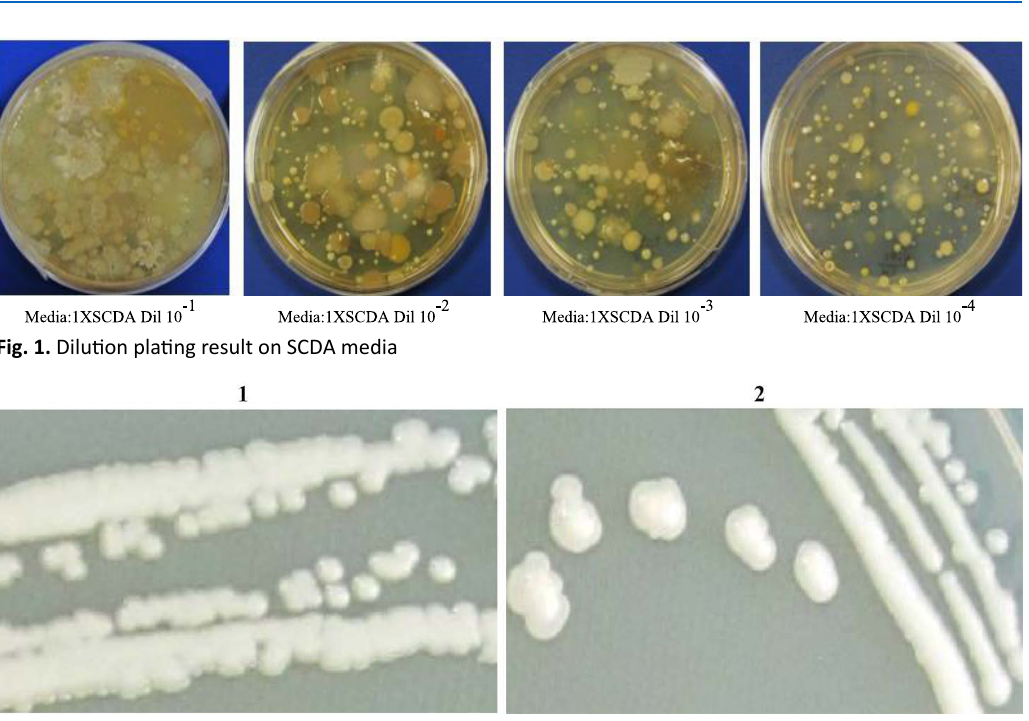
Fig. 2. Pure colony of the isolated on nutrient agar media (1-Strain HYJE003 and 2-Strain HYJE005 )